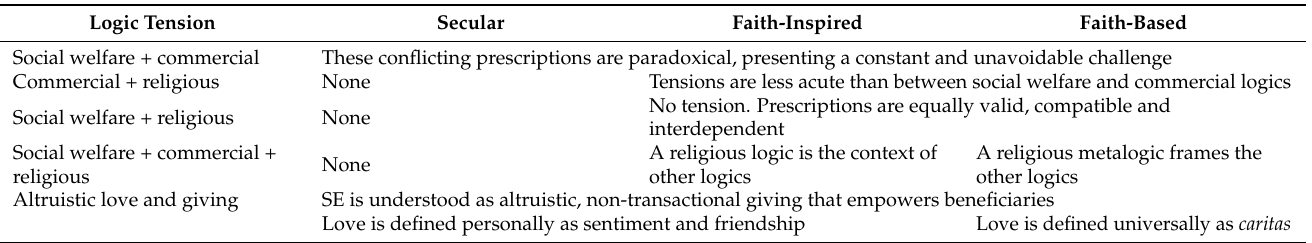
Table 3. Experience and Management of Logic